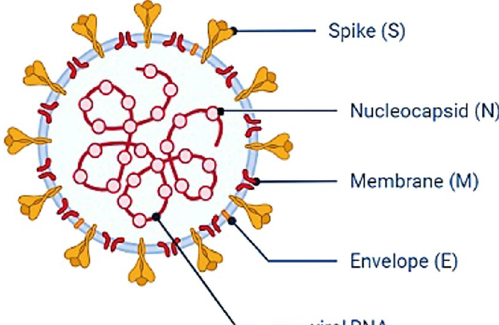
Fig. 2 Coronavirinae subfamily structure. Coronavirinae subfamily contains surface viral proteins, namely spike glycoprotein (S), which mediates interaction with the ACE2 cell surface receptor. Viral membrane glycoproteins (M) and envelope (E) of SARS‑CoV‑2 embedded in the lipid bilayer of viral membranes coat the viral RNA helical nucleocapsid [16] (created with